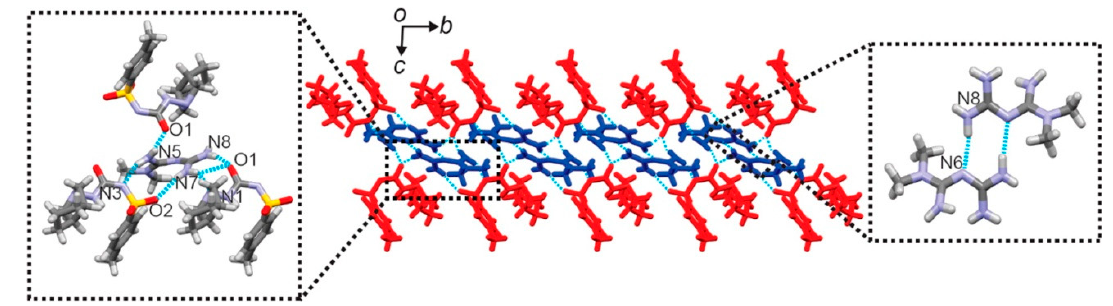
Figure 29. Infinite 1D hydrogen bond chain of MET-GLI crystal along the a -axis (blue for MET and red for GLI). Detailed interaction between MET-MET ( right ) and MET-GLI ( left ) presented in default color according to the different elements. Blue-dashed lines indicate hydrogen bonds. Adapted with